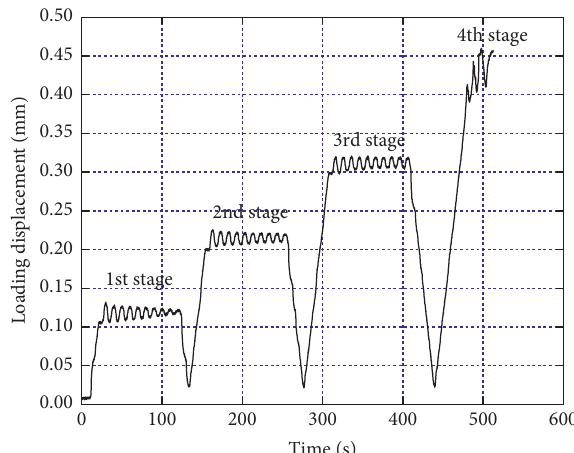
Figure 3: Variation curve of cyclic loading and unloading displacement with time.